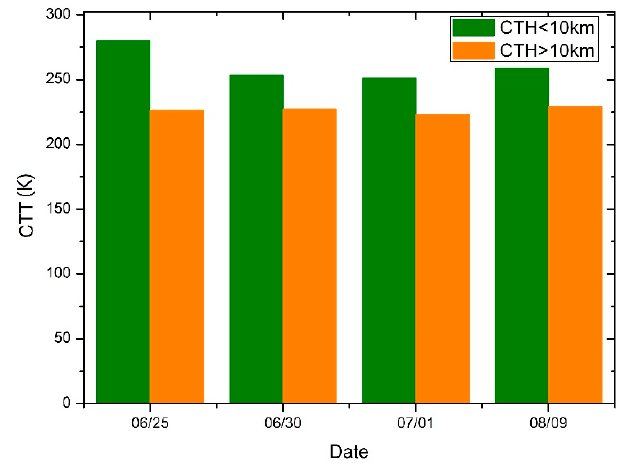
Figure 16. Comparison of the cloud-top temperature (CTT) over the CTH > 10 km region (orange bar) and CTH < 10 km region (green bar). The histograms are for 25 June, 30 June, 1 July and 9 August 2021.